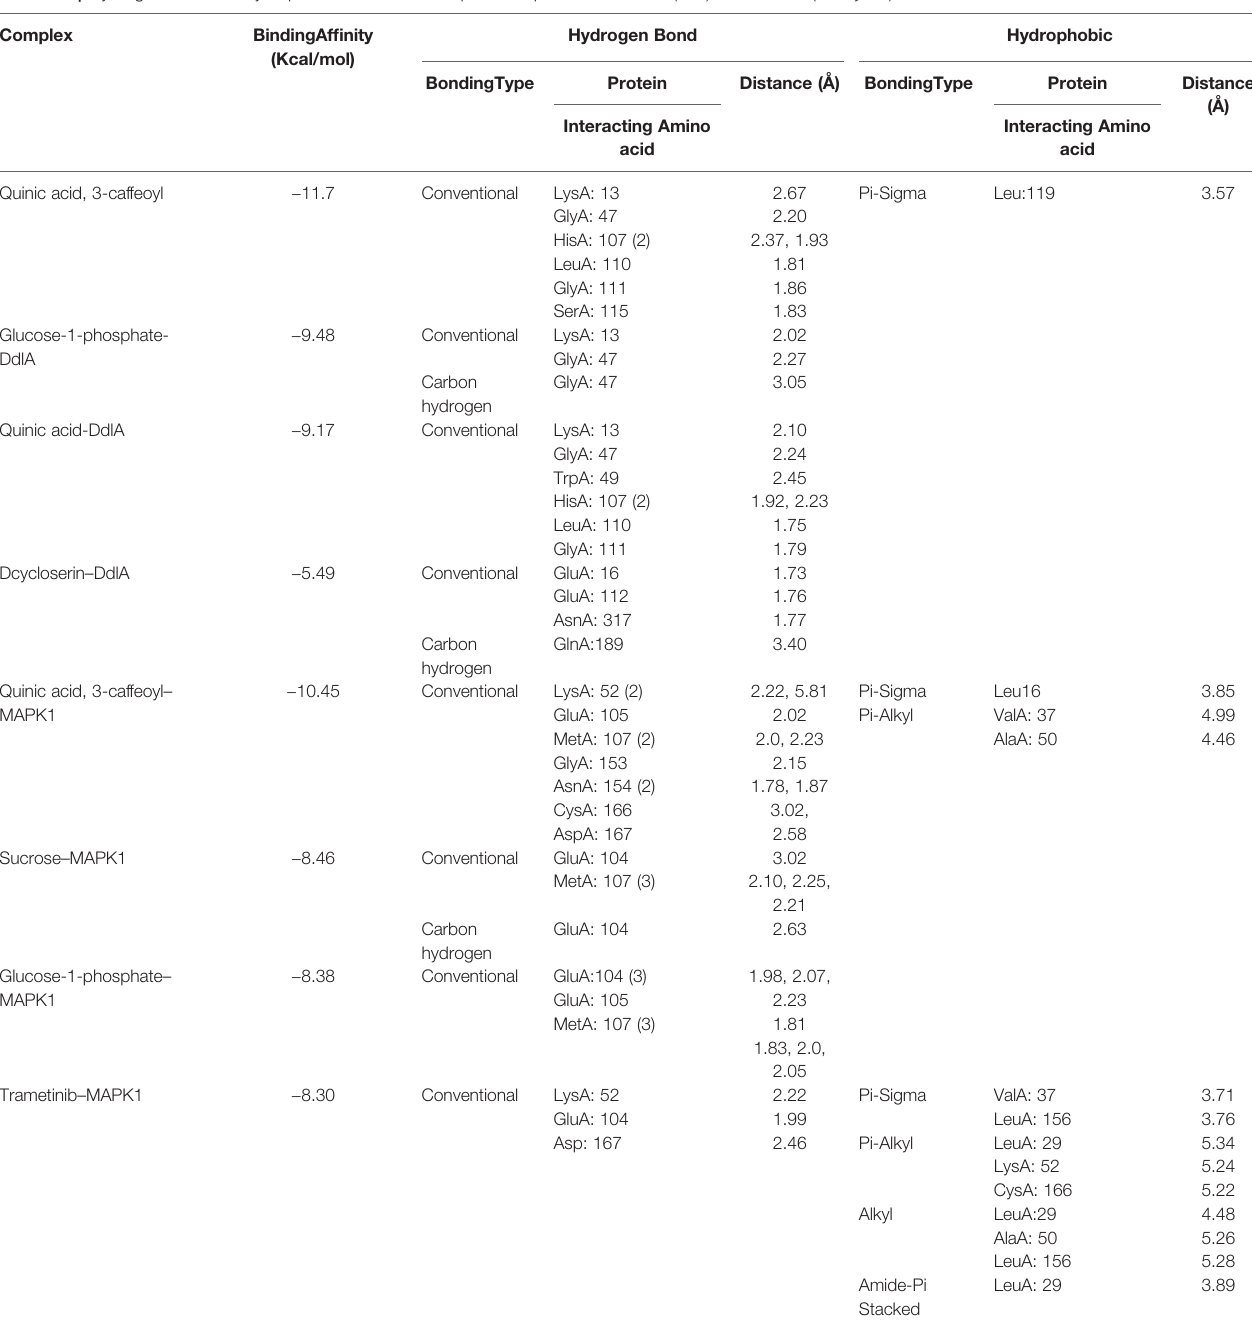
TABLE 5 | Hydrogen bond and hydrophobic interaction of top six compounds with DdlA ( Xoo ) and MAPK1 ( M. oryzae ). Complex BindingAf fi nity Hydrogen Bond Hydrophobic (Kcal/mol) Protein Distance (Å) BondingType Protein Distance